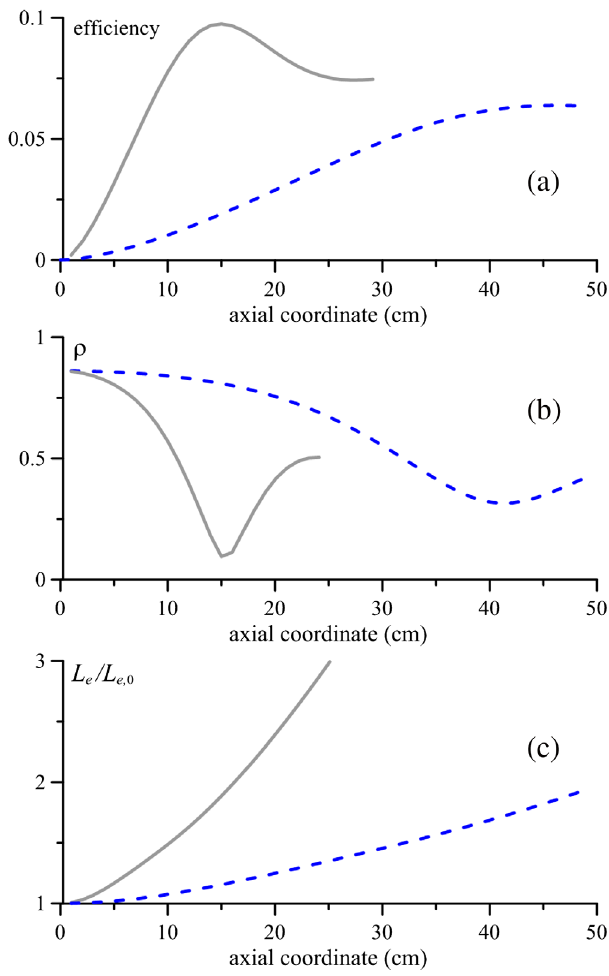
¼ λ = 4 ) bunches e; 0 =L (c) versus the axial e e; 0